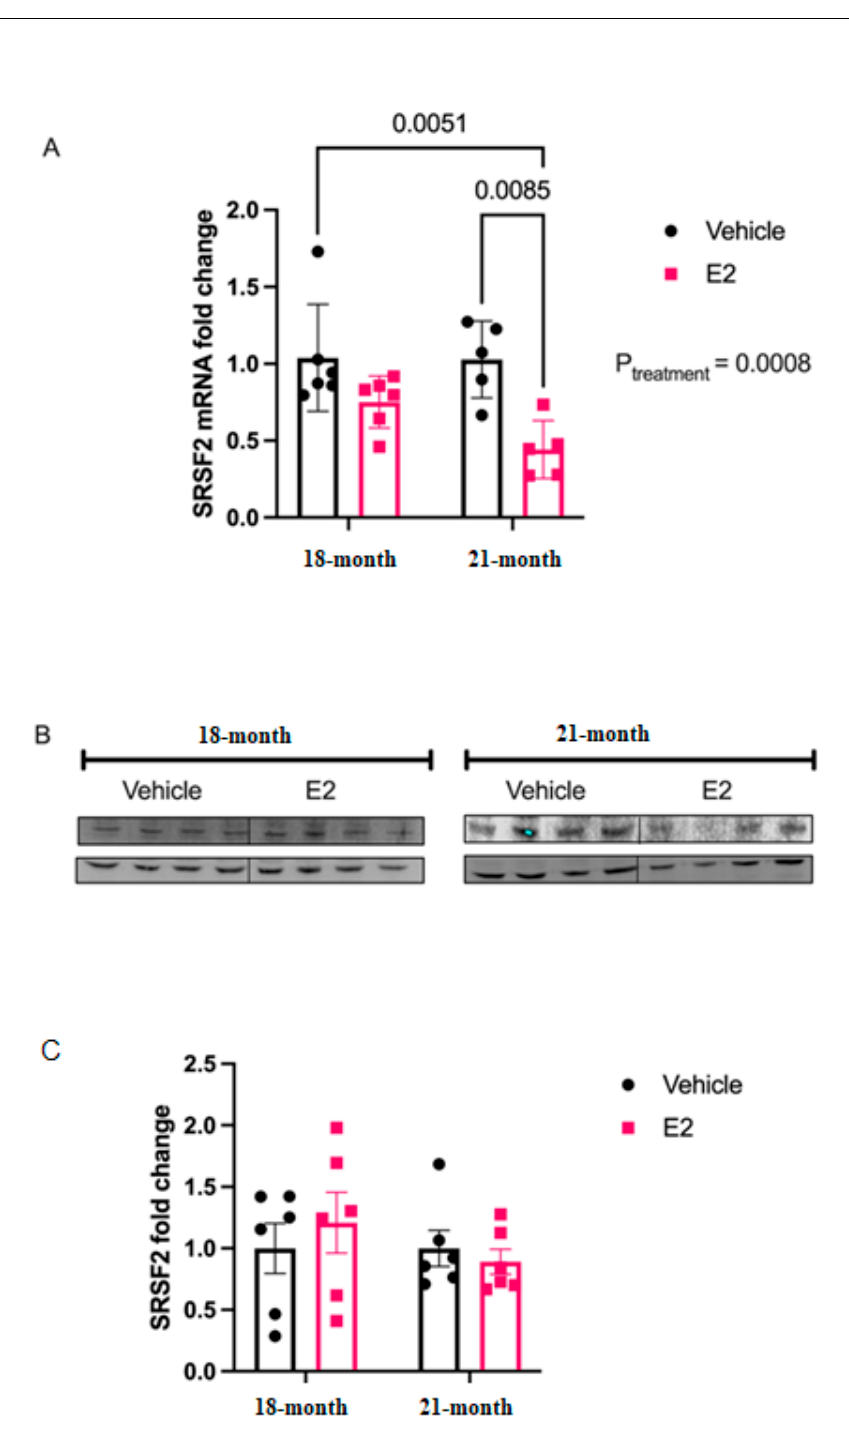
Figure 8. E 2 treatment decreased Srsf2 mRNA, but not protein levels, in the paraventricular nucleus of the hypothalamus in a rat model of menopause. ( A ) RT-qPCR results depicting fold change